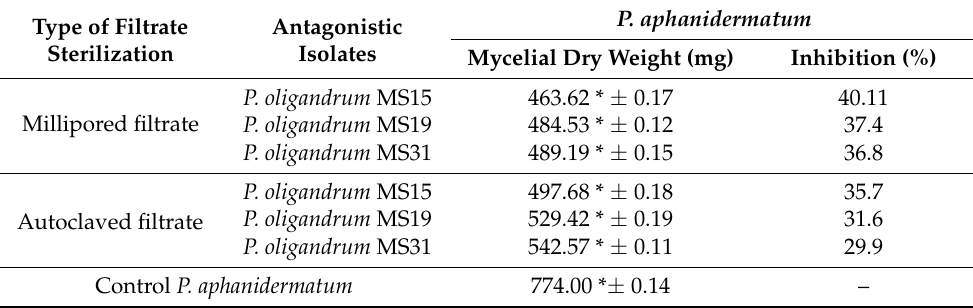
Table 3. Effect of half-strength culture filtrate of P. oligandrum isolates (MS15, MS19 and MS31) on the mycelial dry weight of the pathogenic P. aphanidermatum